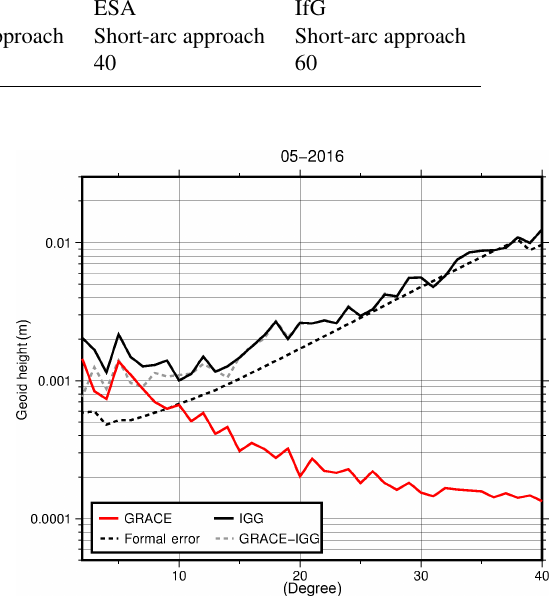
Figure 3. Degree variances for GRACE and Swarm (solution for May 2016). Formal errors as well as the difference degree variance (GRACE minus Swarm) are shown with dotted